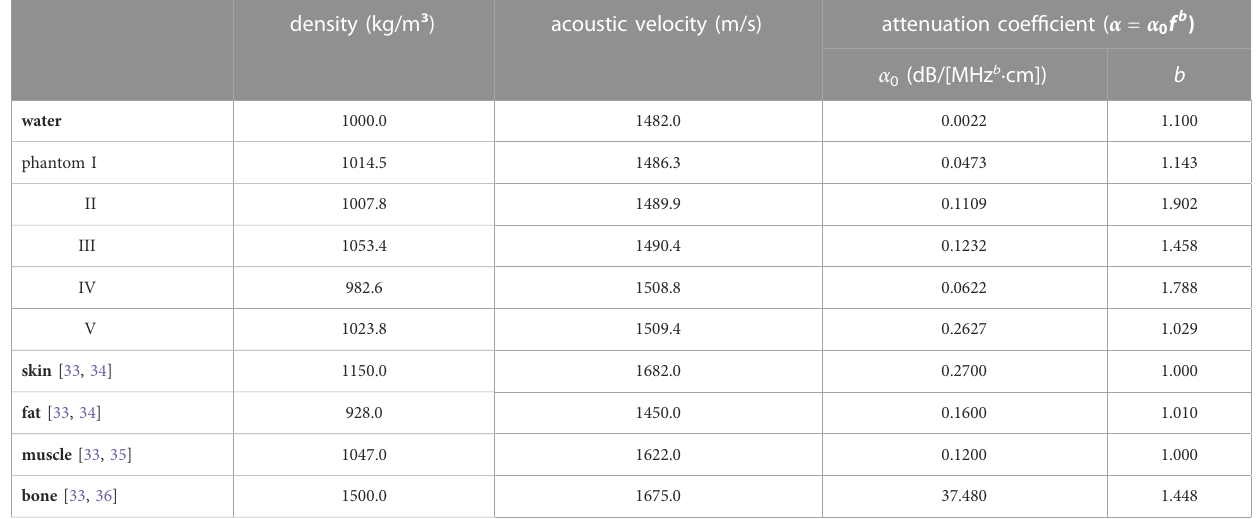
TABLE 1 Acoustic properties of phantom and